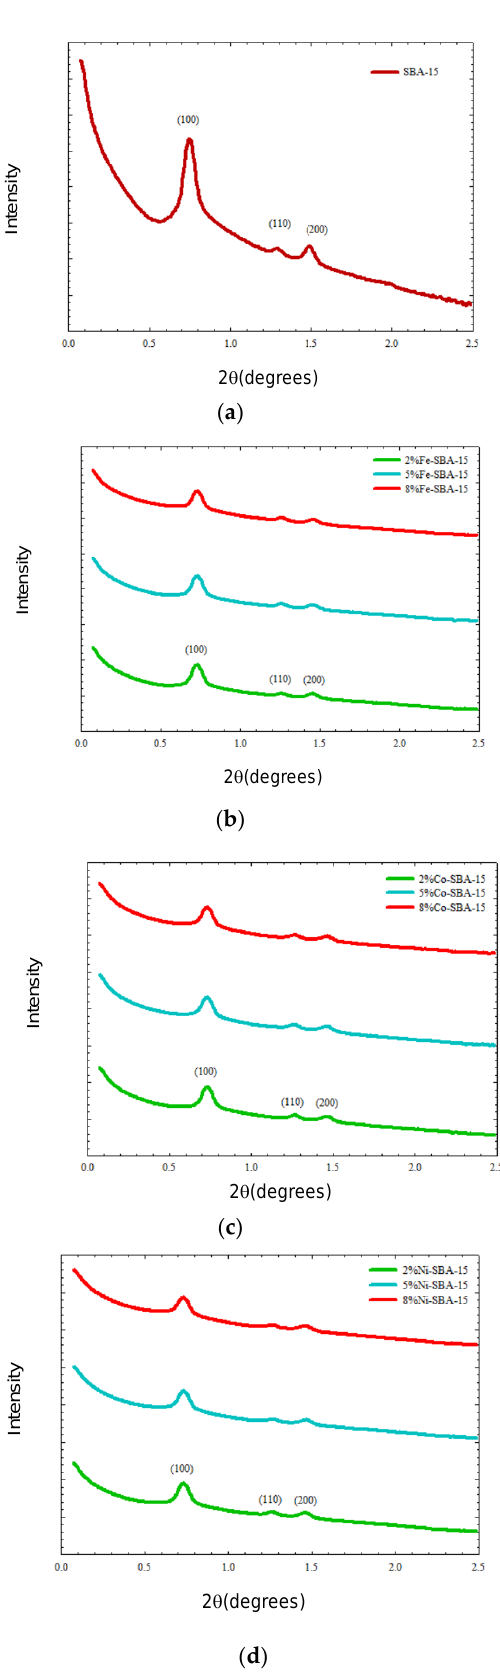
Figure 5. ( a )SAXS analysis of SBA-15.( b )SAXS analysis of 2 – 8wt% of Fe-SBA-15.( c )SAXS analysis of Figure 5. ( a ) SAXS analysis of SBA-15. ( b ) SAXS analysis of 2–8 wt% of Fe-SBA-15. ( c ) SAXS analysis 2 – 8wt% of Co-SBA-15. ( d )SAXS analysis of 2 – 8wt% of Ni-SBA-15. of 2–8 wt% of Co-SBA-15. ( d ) SAXS analysis of 2–8 wt% of SBA-15 and metal oxide-impregnated SBA-15 exhibited a broad silica peak near 23.8°, indicating the amorphous silica on the support (Figure 6).